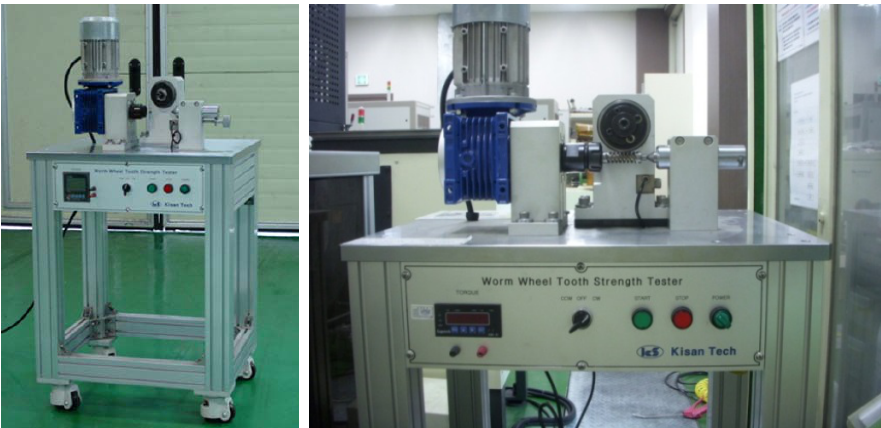
Figure 10. Teeth strength of worm wheel test